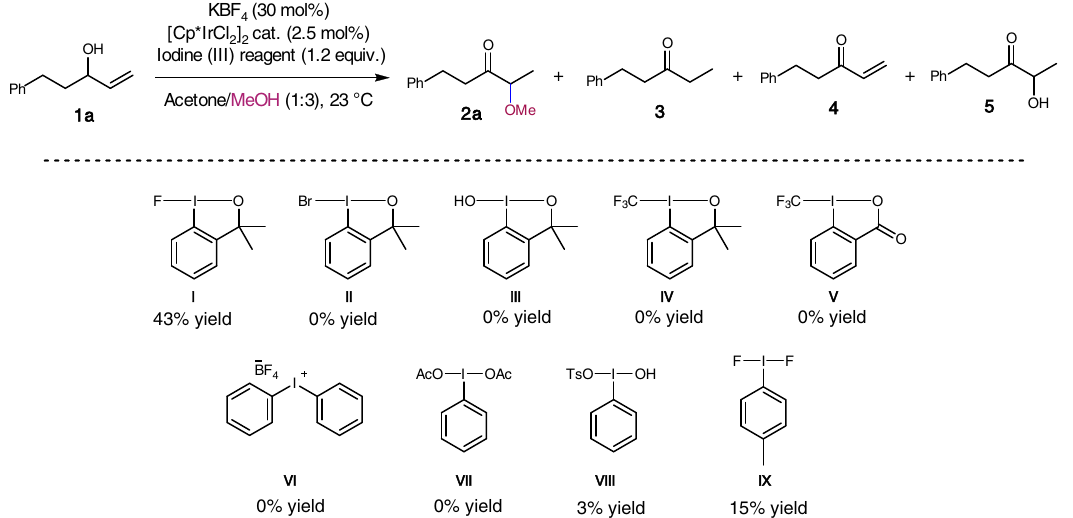
Fig. 2 Iodine(III) reagents screened. Yields of 2a determined by 1 H NMR spectroscopy using an internal standard